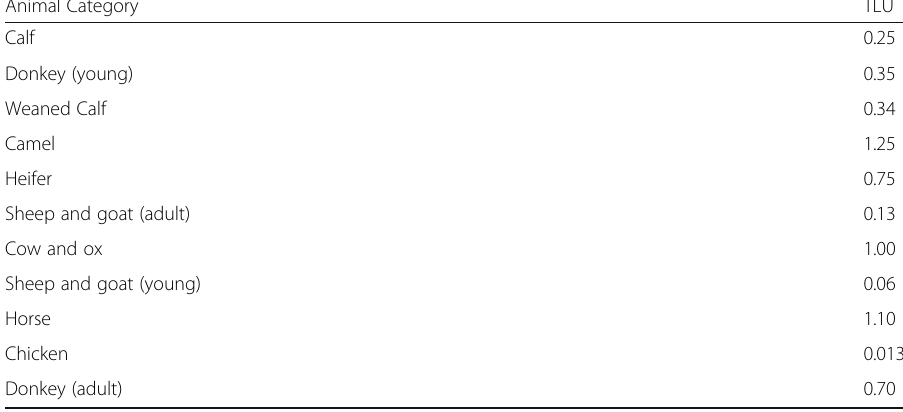
Table 6 Conversion factors used to estimate tropical livestock unit (TLU) equivalents Animal Category